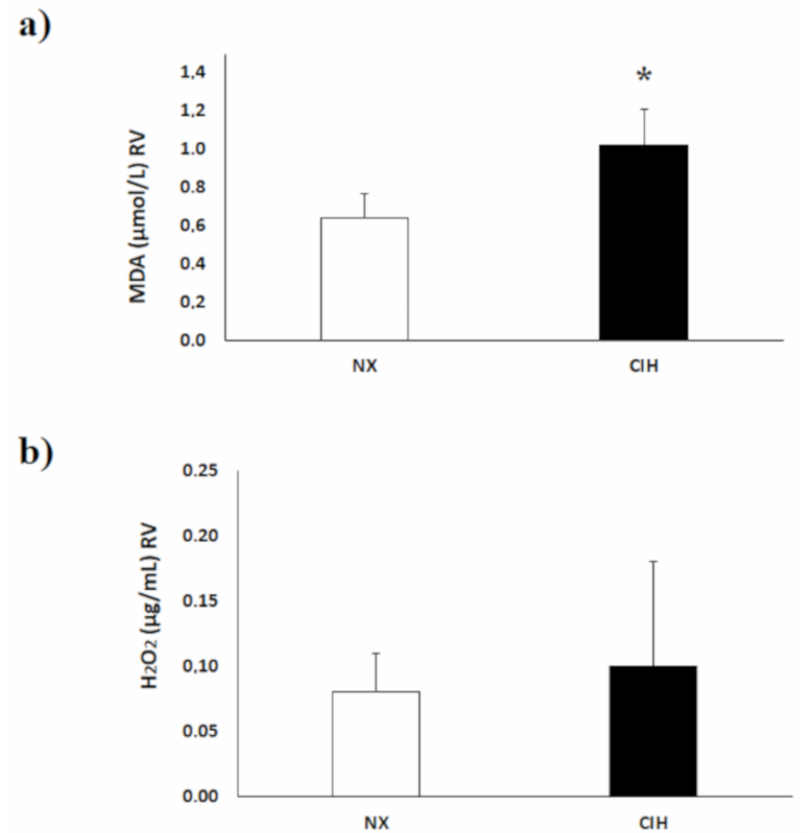
Figure 3. ( a ) Malondialdehyde (MDA) concentrations in the right ventricle tissue (RV); ( b ) hydrogen peroxide (H 2 O 2 ) concentration in the RV under normoxia (NX); n = 10 and chronic intermittent hypobaric hypoxia (CIH); n = 10. The values are the mean (x) ± standard error (SE). * p < 0.05: CIH